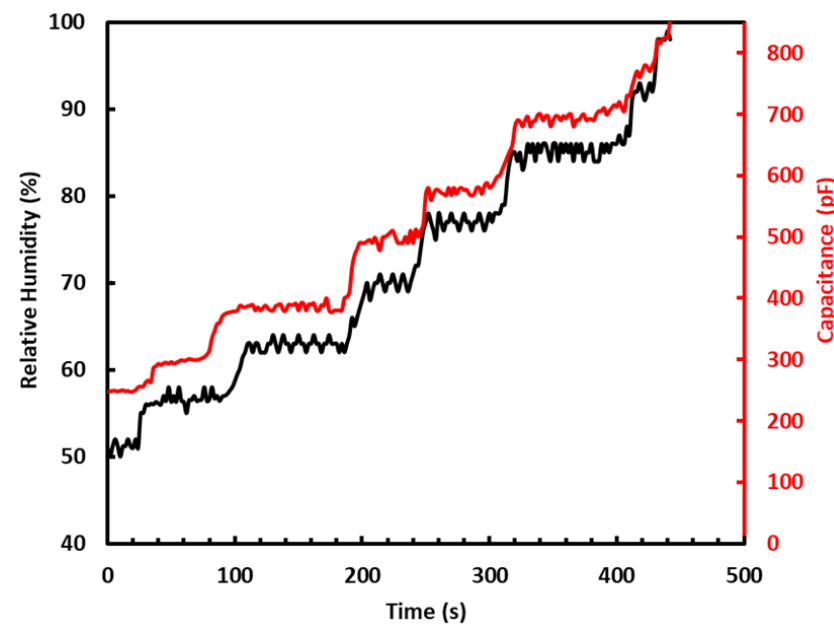
Figure 5. Change in %RH and capacitance of sensor as a function of time.